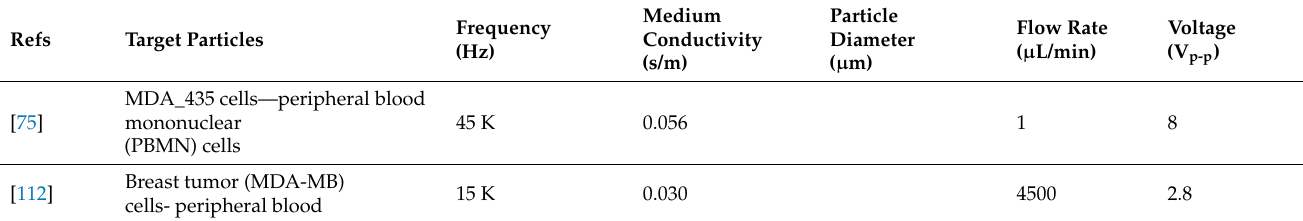
Table 5. FFF-DEP methods’ reported